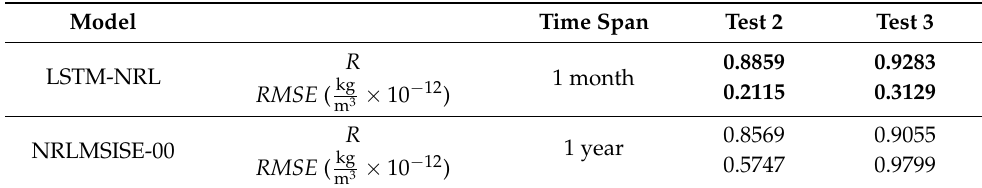
Table 4. The overall performance of the LSTM-NRL in Test 2 and Test 3. It is noted that the best results, in terms of RMSE and R , are bold in the table.